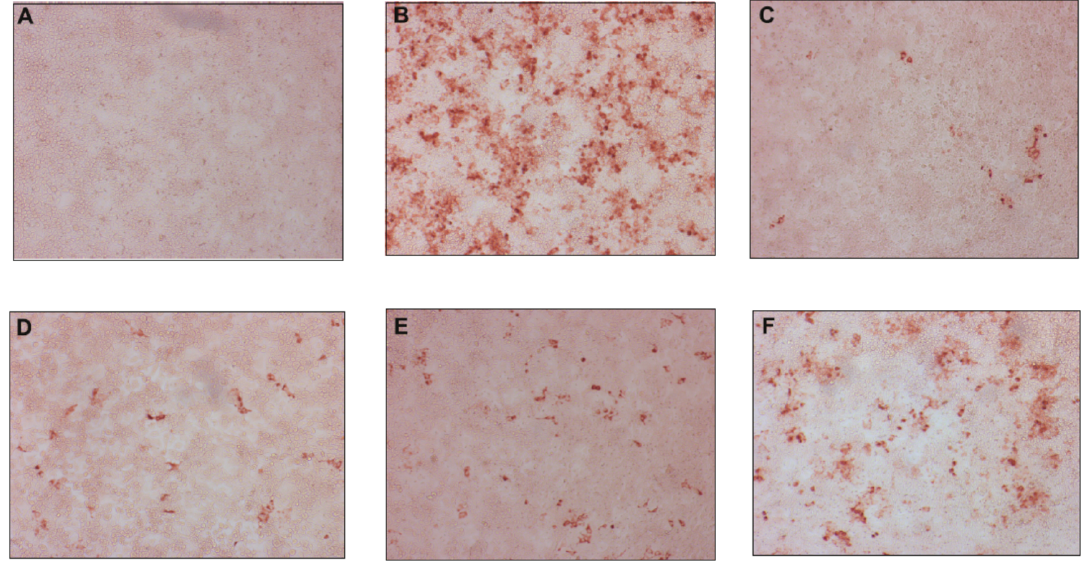
Figure 2. Effect of compound 9 on pseudo-plaque formation in hepatitis C virus (HCV)-infected Huh-7.5 cells. Huh-7.5 cells were mock infected ( A ) or infected with HCV at a MOI of 0.1 ( B – F ). At 3 h p.i., the virus was removed, and the cells were treated with various concentrations of compound 9 (( C ) 10 µ M, ( D ) 8 µ M, ( E ) 6 µ M, and ( F ) 4 µ M) or left untreated (positive control ( B )). Three days post infection, cells were fixed, and HCV pseudo-plaques were detected using anti-HCV core